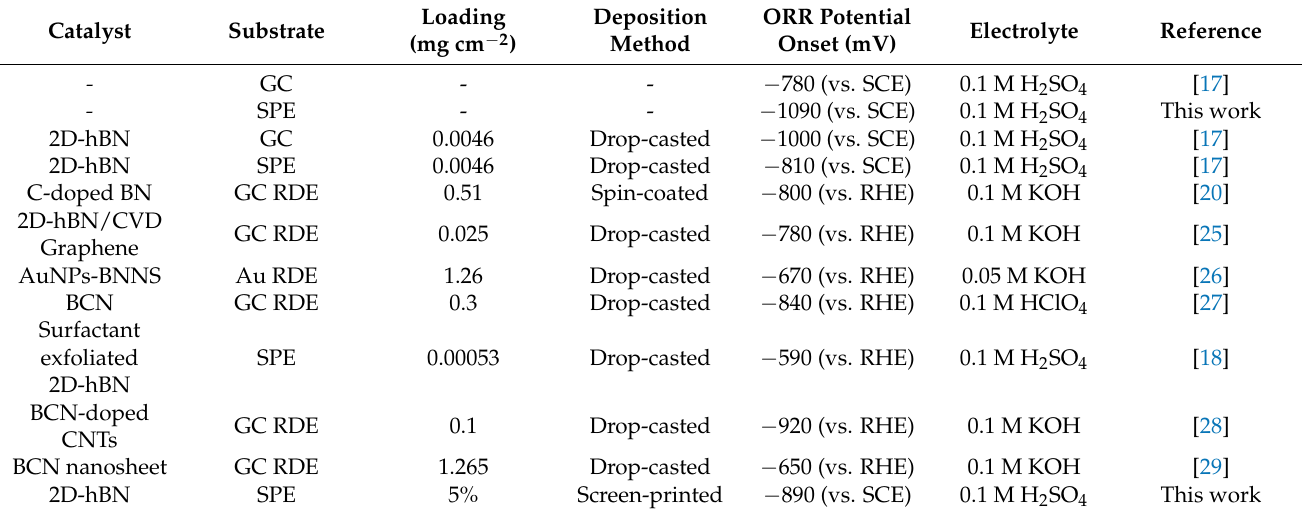
Table 1. Comparison of 2D-hBN electrocatalysts that have been utilised towards